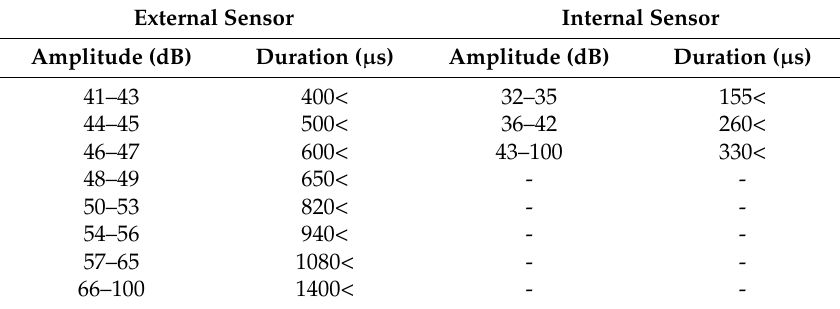
Figure 5. Amplitude and cumulative signal strength of AE data in terms of concrete age. ( a ) Confined specimen; ( b ) Unconfined specimen; ( c ) Control specimen. Table 1. Duration-amplitude rejection limits.